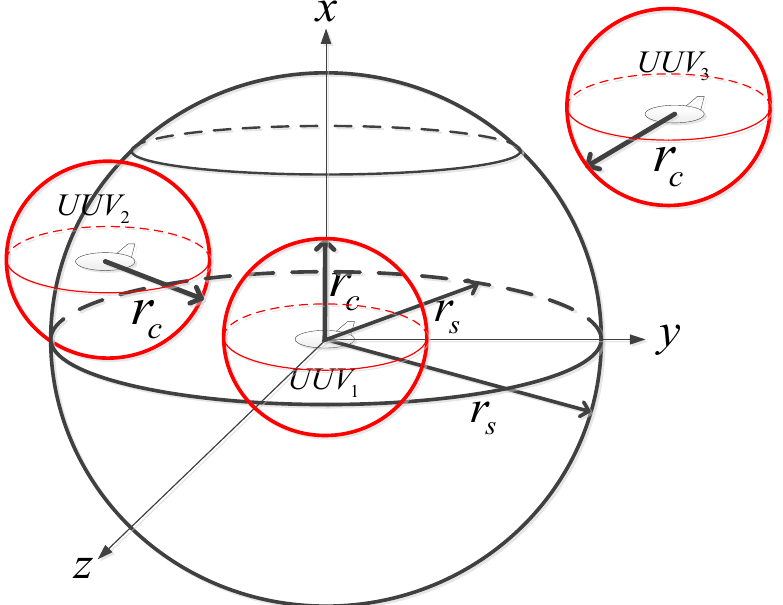
Figure 2. The collision sphere and the collision avoidance sphere of UUVs.